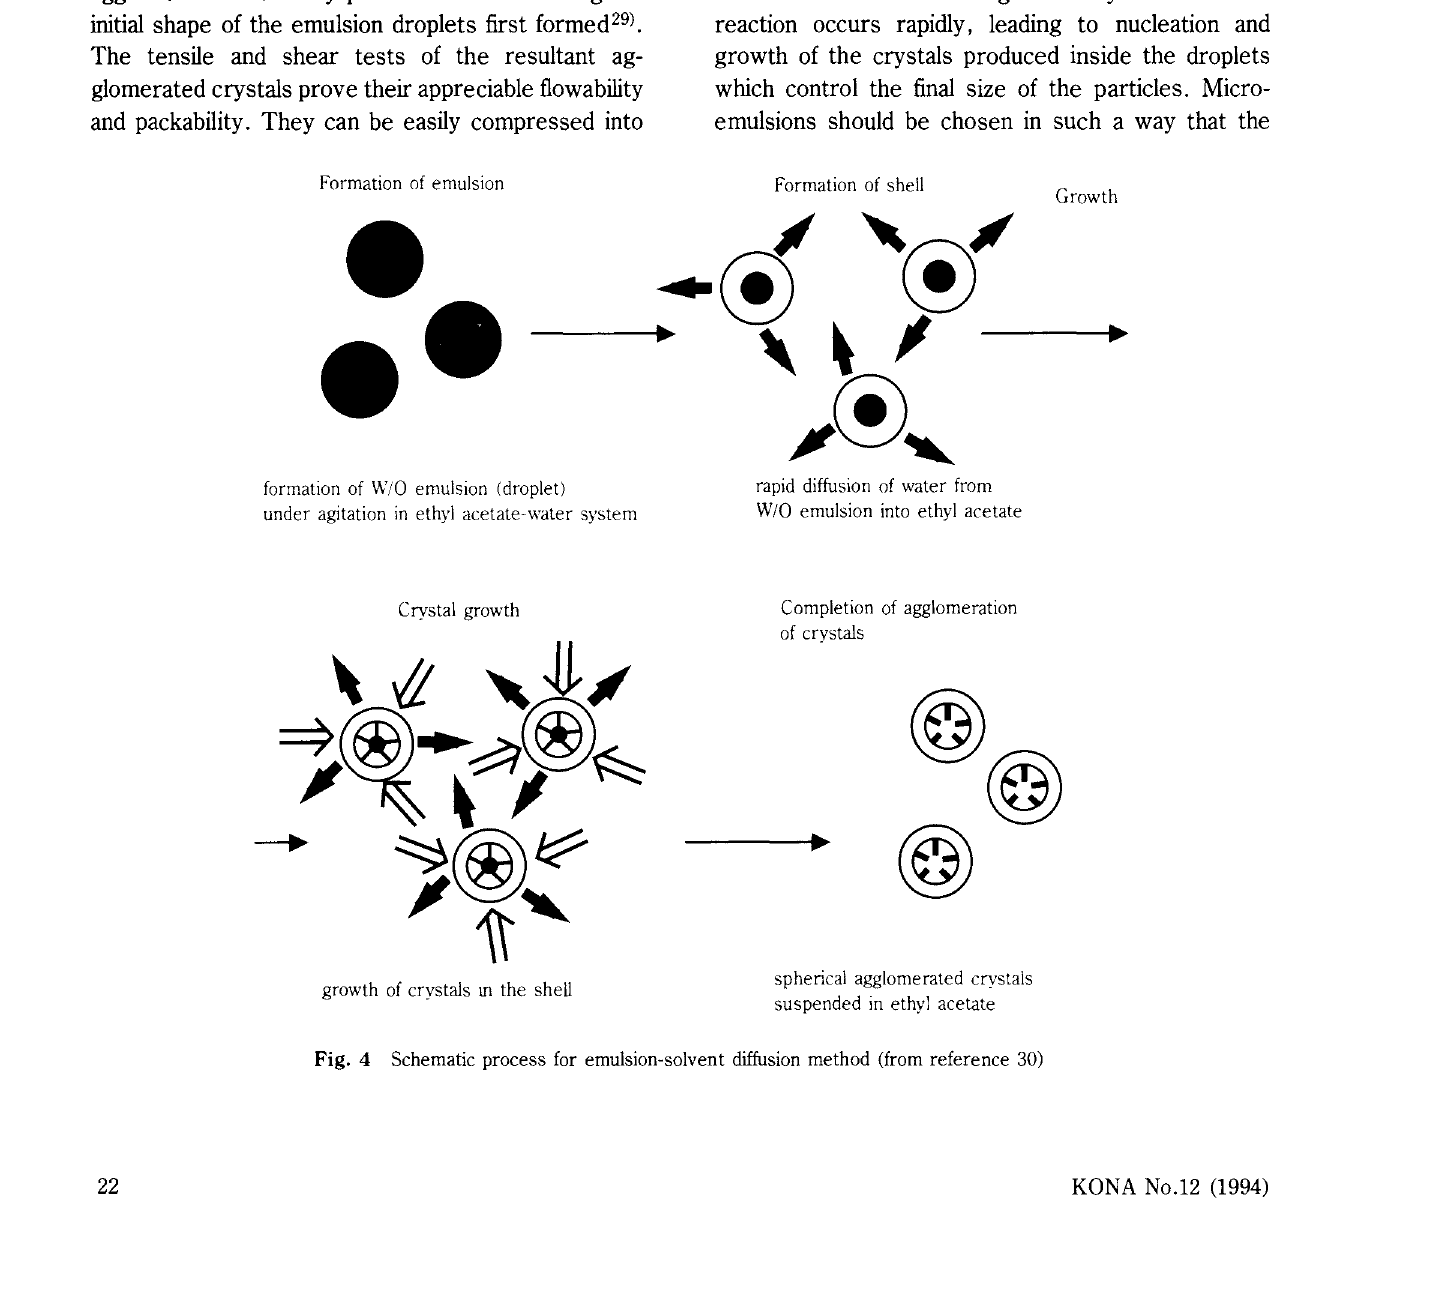
Fig. 4 Schematic process for emulsion~solvent diffusion method (from reference